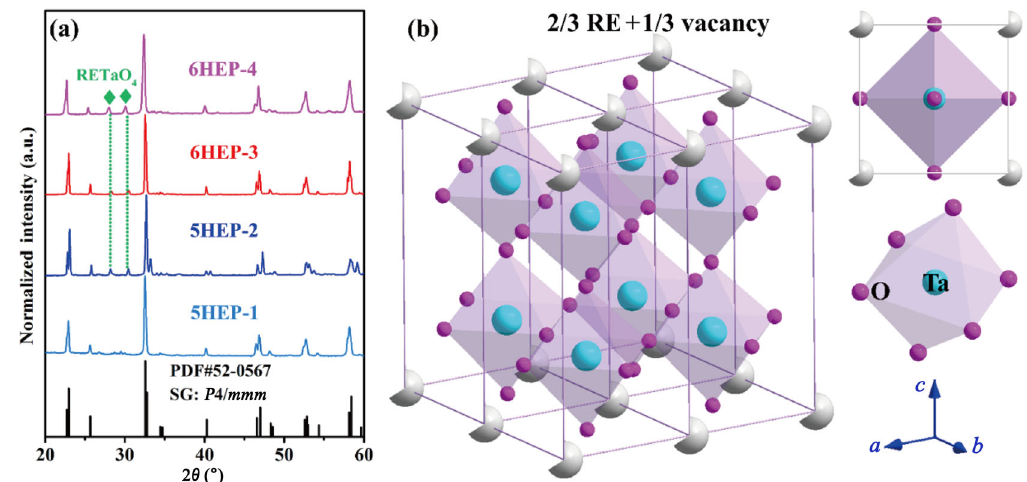
Fig. 1 Characterization of the crystal structure of (La 1/5 Pr 1/5 Dy 1/5 Ho 1/5 Tm 1/5 )Ta 3 O 9 (5HEP-1), (Gd 1/5 Dy 1/5 Ho 1/5 Er 1/5 Tm 1/5 )Ta 3 O 9 (5HEP-2), (La 1/6 Sm 1/6 Eu 1/6 Dy 1/6 Ho 1/6 Tm 1/6 )Ta 3 O 9 (6HEP-3), and (Eu 1/6 Gd 1/6 Dy 1/6 Ho 1/6 Er 1/6 Tm 1/6 )Ta 3 O 9 (6HEP-4): (a) normalized XRD patterns; (b) 2 × 2 × 1 unit cell, where the grey ball represents an A-site 2/3 RE atom with a 1/3 vacancy, the blue ball represents a B-site Ta atom, and the purple ball represents an oxygen atom. Table 1 Design composition, sample name, lattice parameters ( a , b , and c ), unit cell volume ( V ), theoretical density ( ρ 0 ), and porosity ( ϕ ) of HEP RETa 3 O 9 ceramics